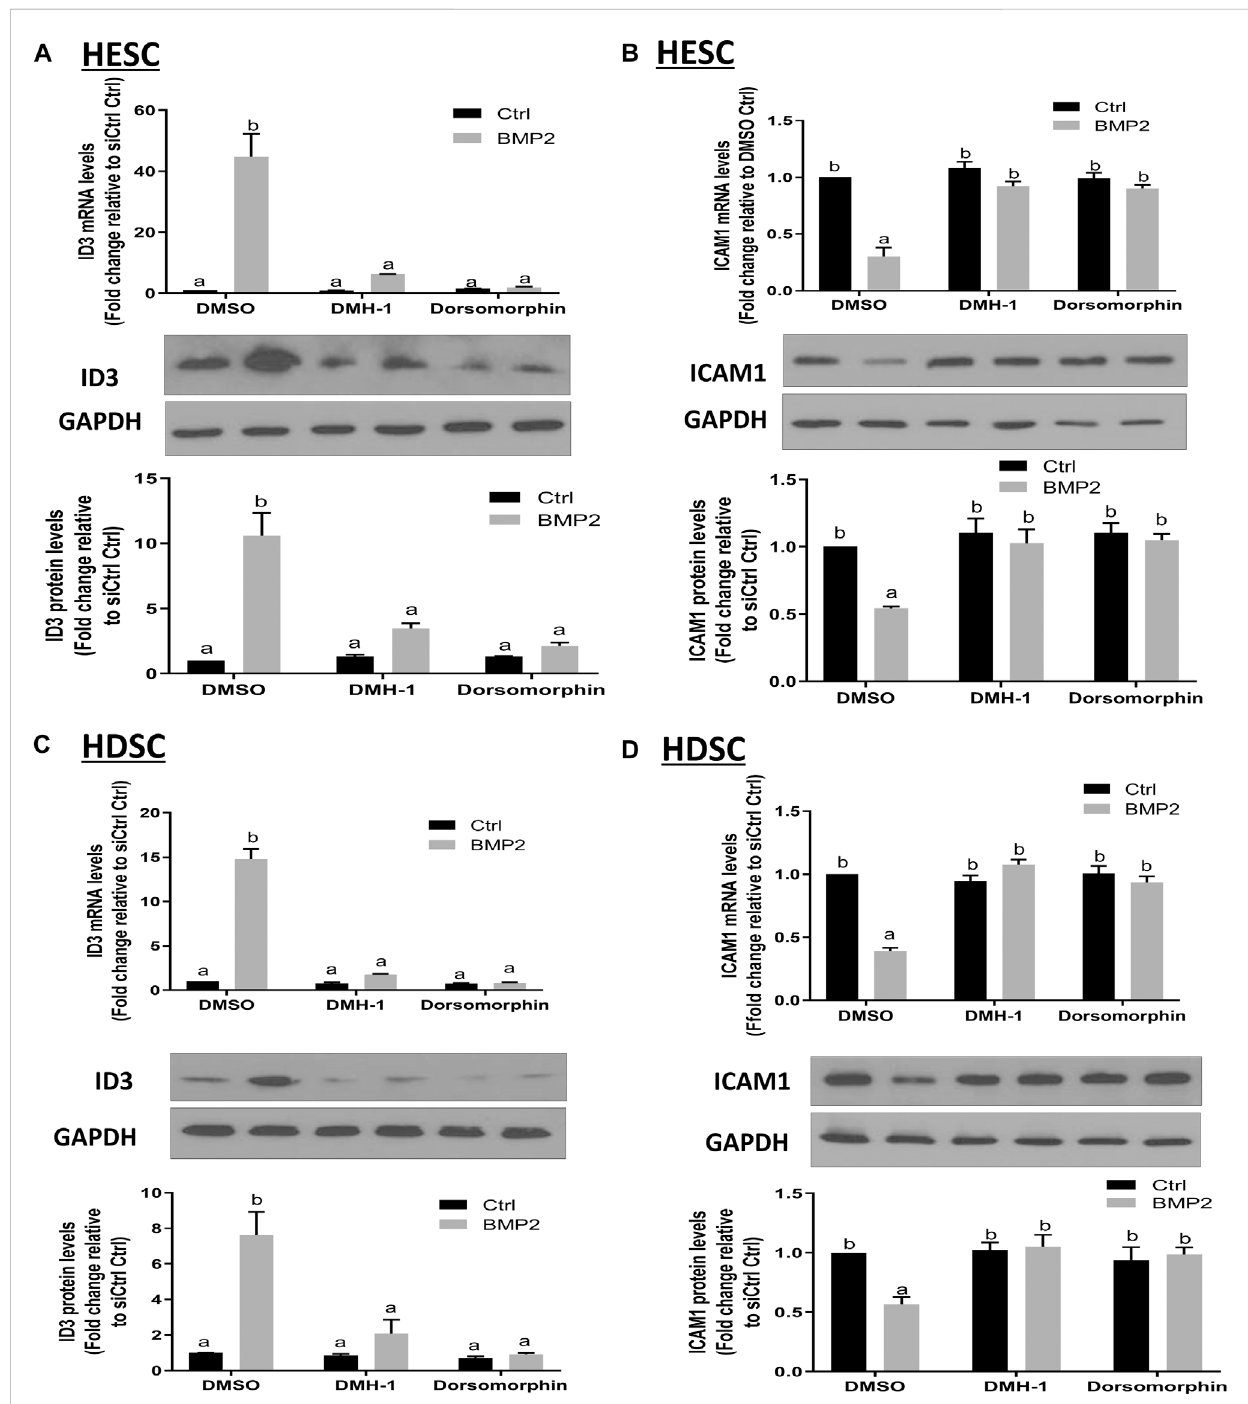
FIGURE 7 The effects of speci fi c TGF- β type I inhibitors on BMP2-induced upregulation of ID3 expression and downregulation of ICAM1 expression in HESCs andHDSCs.(AandB)HESCswerepretreatedwithdimethylsulfoxide(DMSO),DMH-1(0.25 µM),ordorsomorphin(10 µM)for1 h,andthecellswerethen treatedwith25 ng/mlBMP2foranadditional24 h.ThemRNAandproteinlevelsofID3 (A) andICAM1 (B) wereexaminedusingRT-qPCRandWesternblot analysis, respectively. (C,D) HDSCs were pretreated with DMSO, DMH-1 (0.25 µM), or dorsomorphin (10 µM) for 1 h, and the cells were then treated with 25 ng/mL BMP2 for an additional 24 h. The mRNA and protein levels of ID3 (C) and ICAM1 (D) were examined using RT-qPCR and Western blot analysis, respectively. The results are expressed as the mean ± S.E.M. of at least three independent experiments. Different letters indicate a signi fi cant difference ( p <